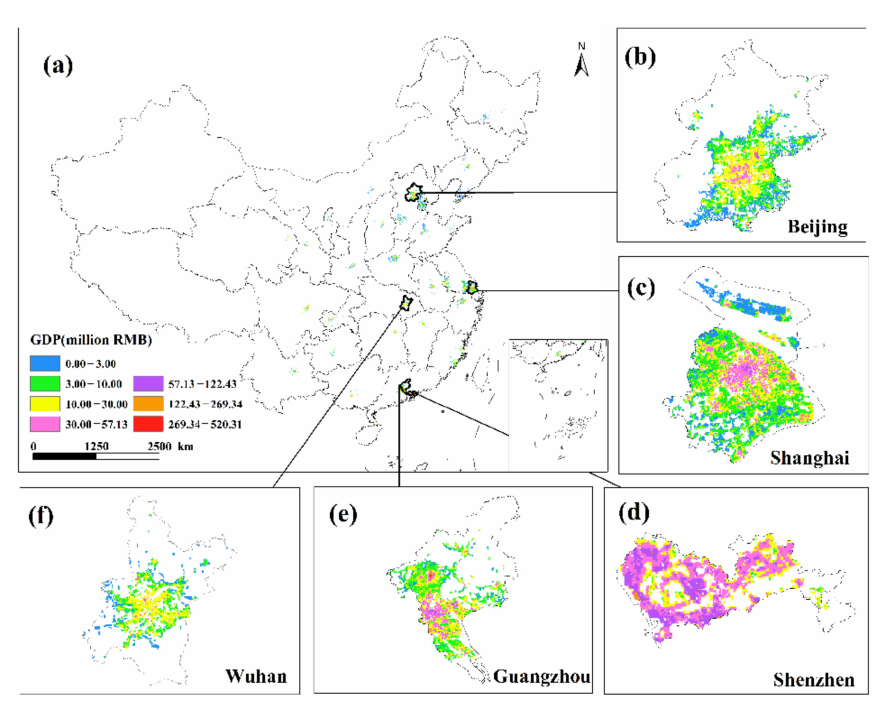
Figure 9. The spatial distribution of the total GDP of the secondary and tertiary industries in February 2020. ( a ) The spatial distribution of the total GDP in 34 Chinese cities; ( b ) Beijing; ( c ) Shanghai; ( d ) Shenzhen; ( e ) Guangzhou; ( f )